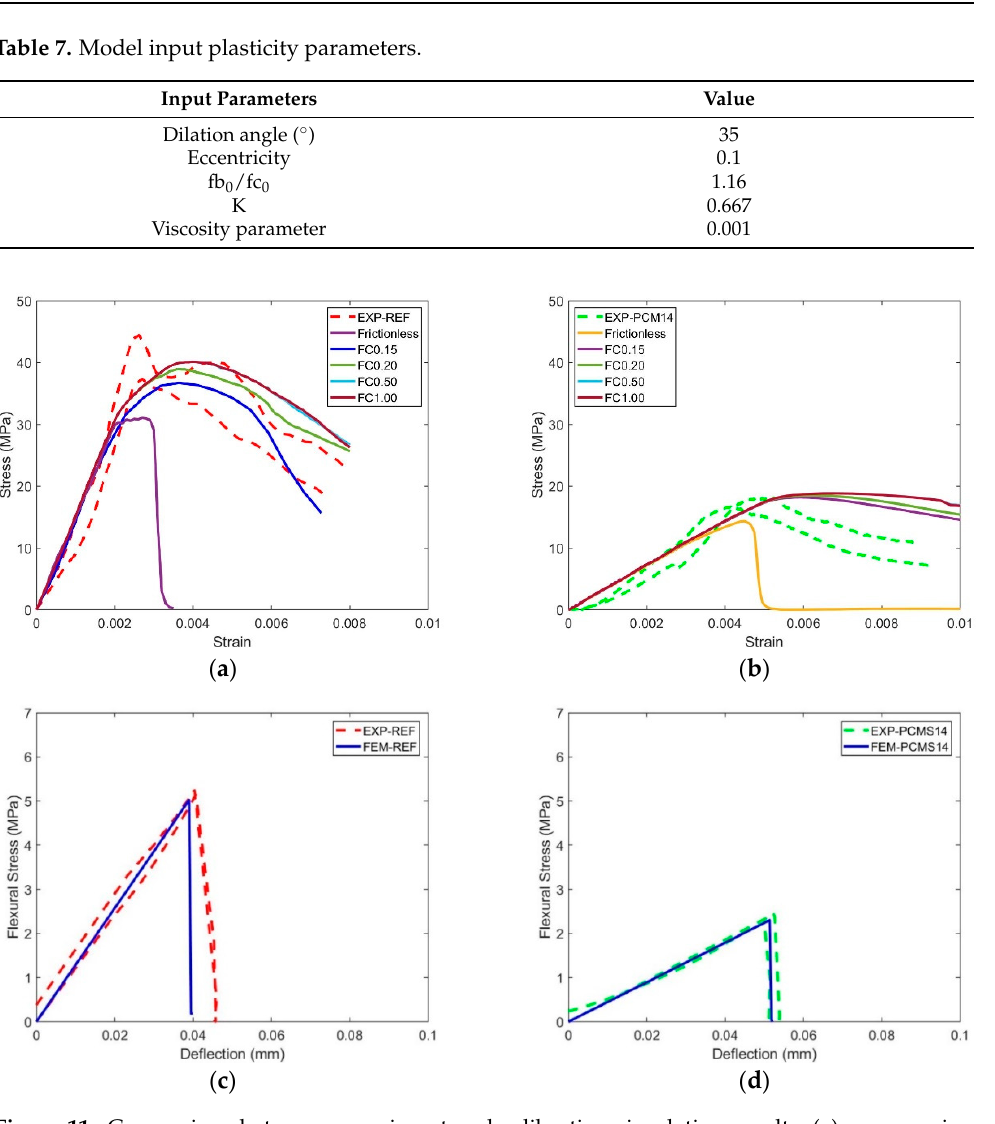
Figure 11. Comparison between experiment and calibration simulation results, ( a ) compression results of REF, ( b ) compression results of PCM14, ( c ) bending results of REF and ( d ) bending results of PCM14; the dashed lines indicate experimental measurement uncertainties.